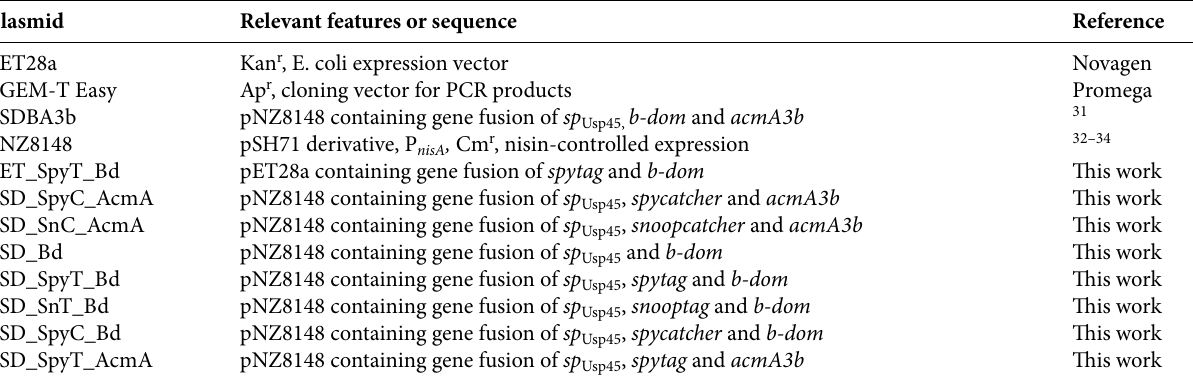
Table 2. Plasmids used in this study Plasmid Relevant features or sequence